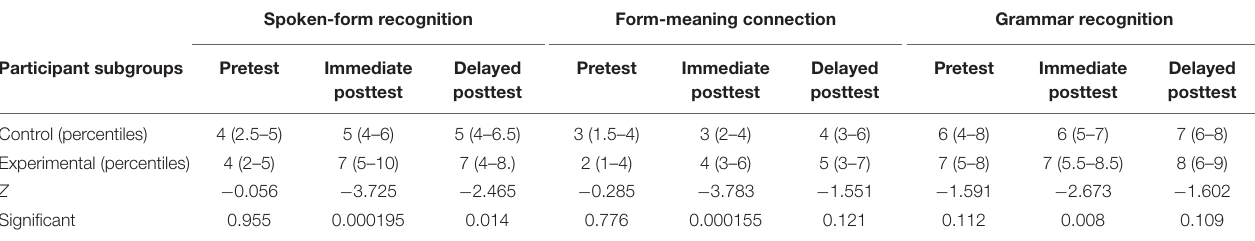
TABLE 7 | Mann–Whitney U Test statistics.